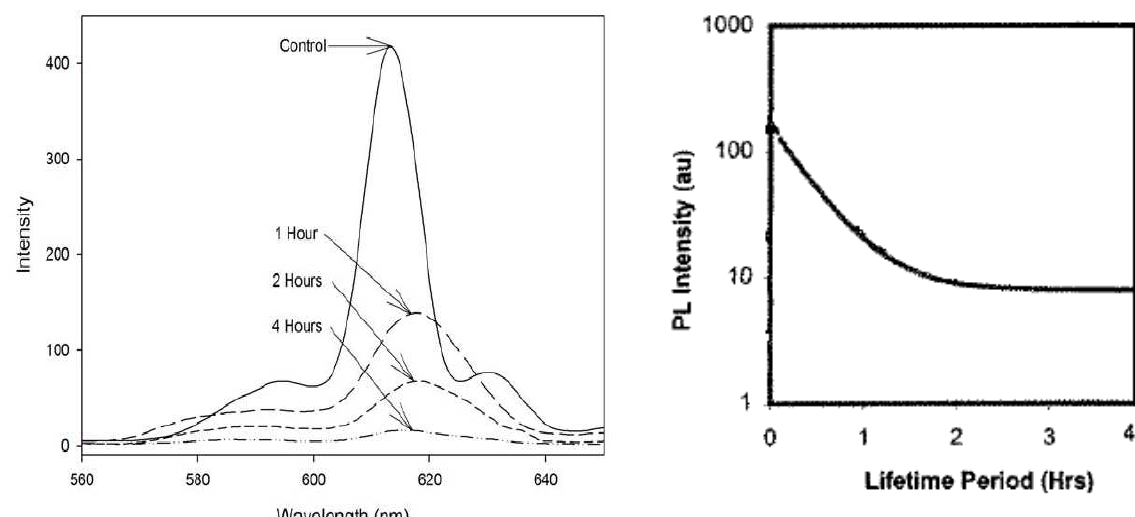
O phosphor after 2 3